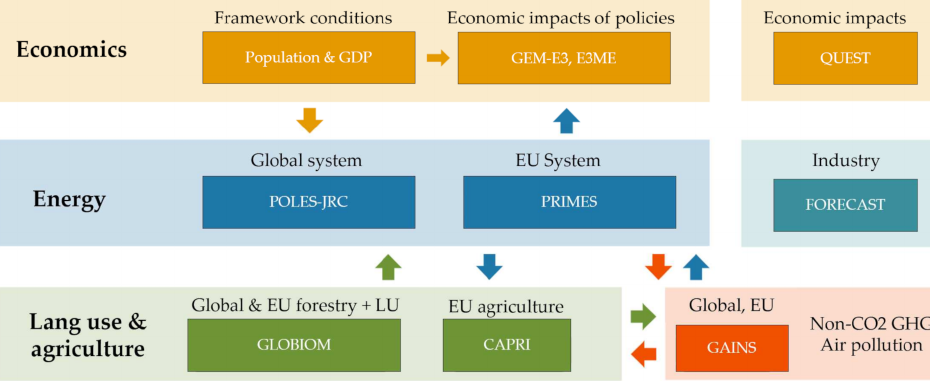
Figure 6. The European Commission modelling suite for integrated modelling of the economy, energy, land use and agriculture and air pollution